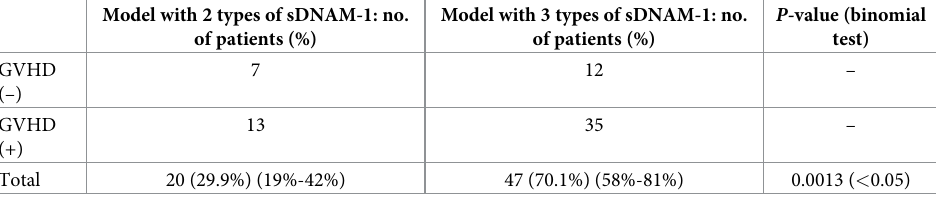
Model with 3 types of sDNAM-1: no. of patients (%)